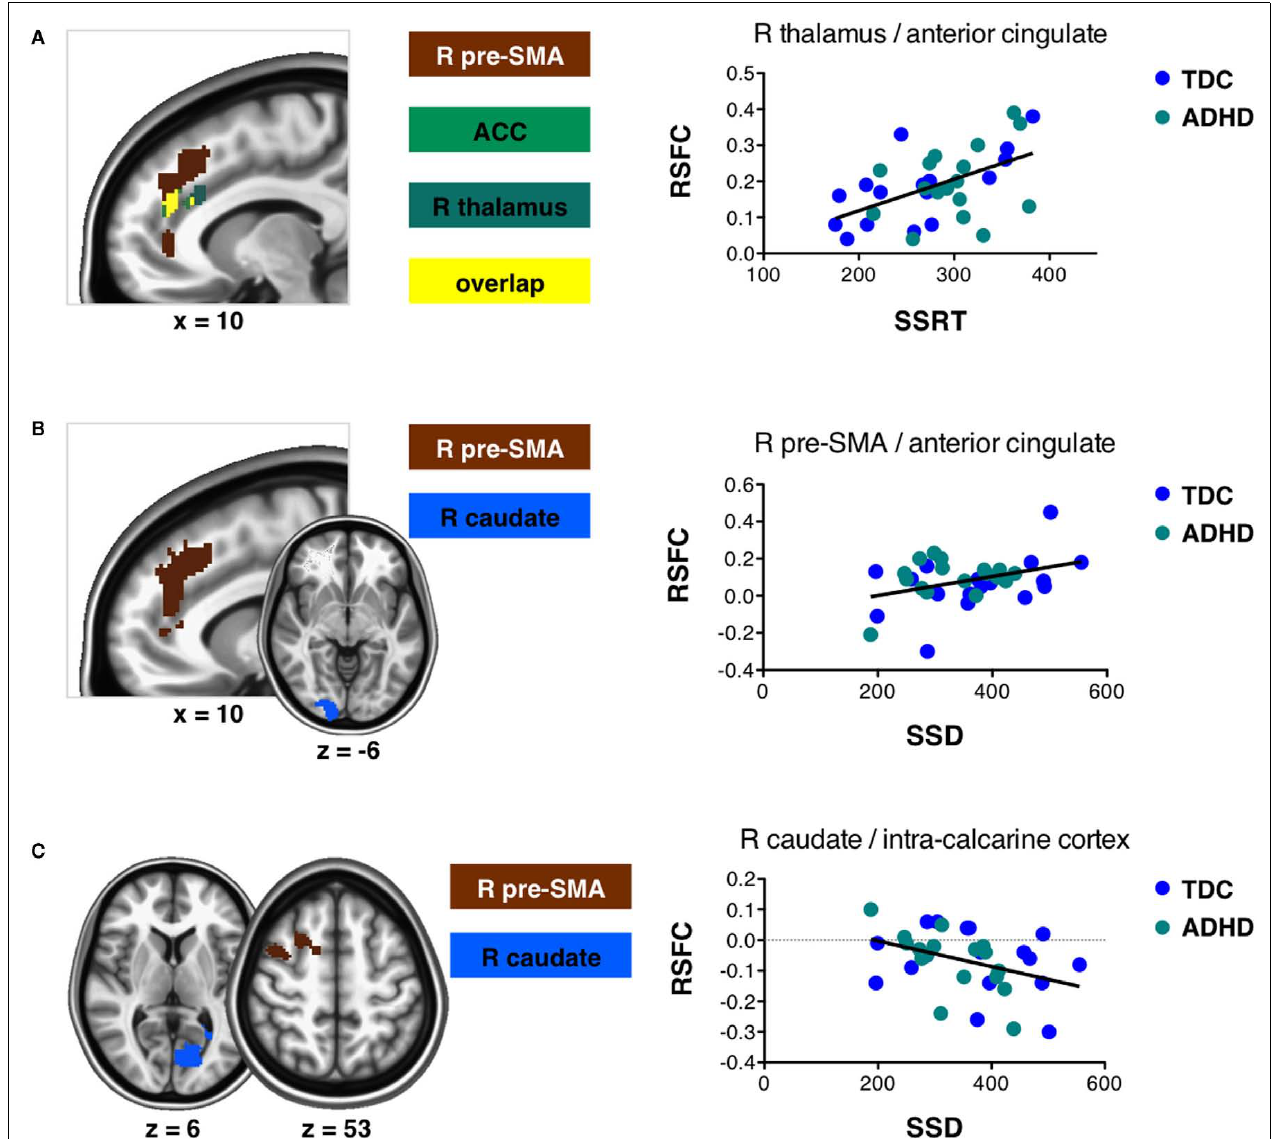
and SSRT. (B) Regions exhibiting a significantly positive relationship between RSFC and SSD. (C) Regions exhibiting a significantly negative relationship between RSFC and SSD. Graphs illustrate example relationships. Data points are shown for typically developing children (TDC) and children with ADHD. R, right; pre-SMA, pre-supplementary motor area; ACC, anterior cingulate cortex.